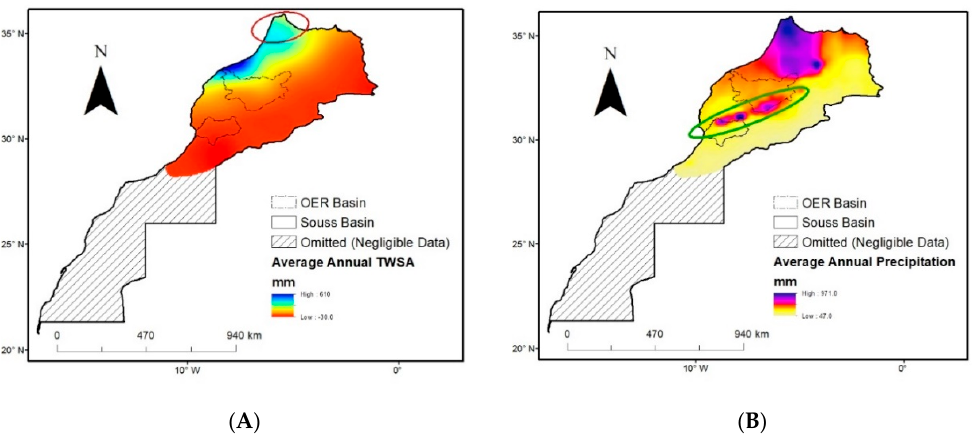
Figure 4. ( A ) Average annual GRACE-derived TWS anomaly (2002–2016); ( B ) Average annual TMPA-derived precipitation (2002–2016). Also shown are areas of high correlation between TWS anomaly and precipitation (red oval) and high precipitation yet low TWS anomaly (green oval).